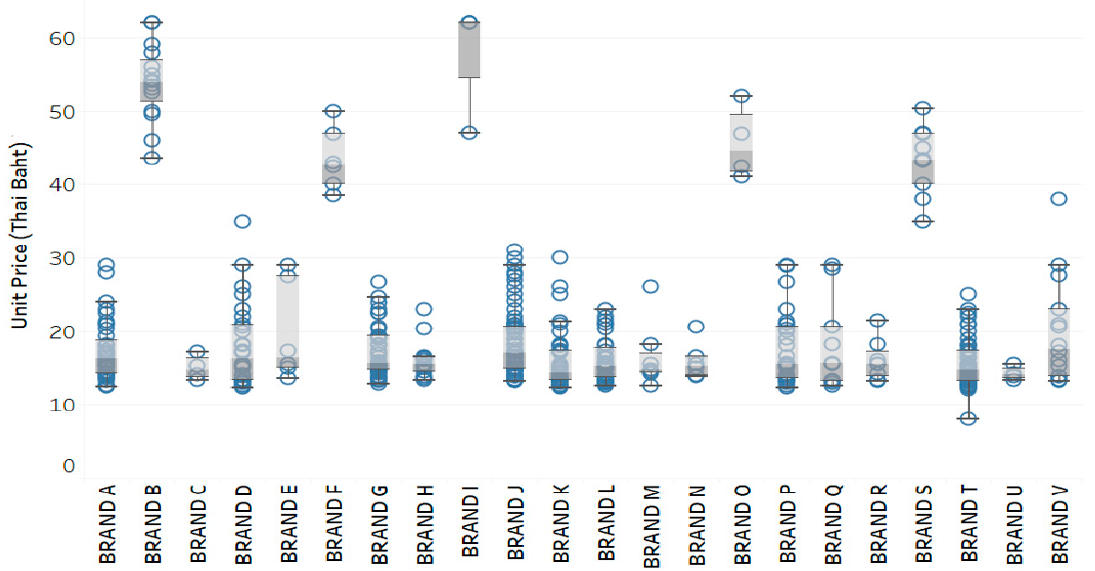
Figure 4. Example of distribution in drug prices across different brands of the omeprazole (40 mg) powder for solution for injection drug (ATC: A02BC01).